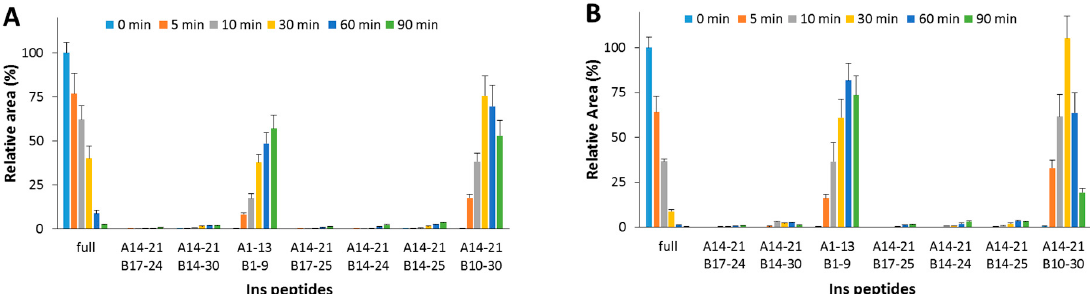
Figure 2. Hydrolytic pattern of the time-course Ins degradation catalyzed by IDE. The content of the full-length substrate (full) and the main hydrolytic peptides was detected in the absence ( A ) and in the presence ( B ) of OFQ/N, co-incubated with Ins and IDE at 37 °C for 90 min.